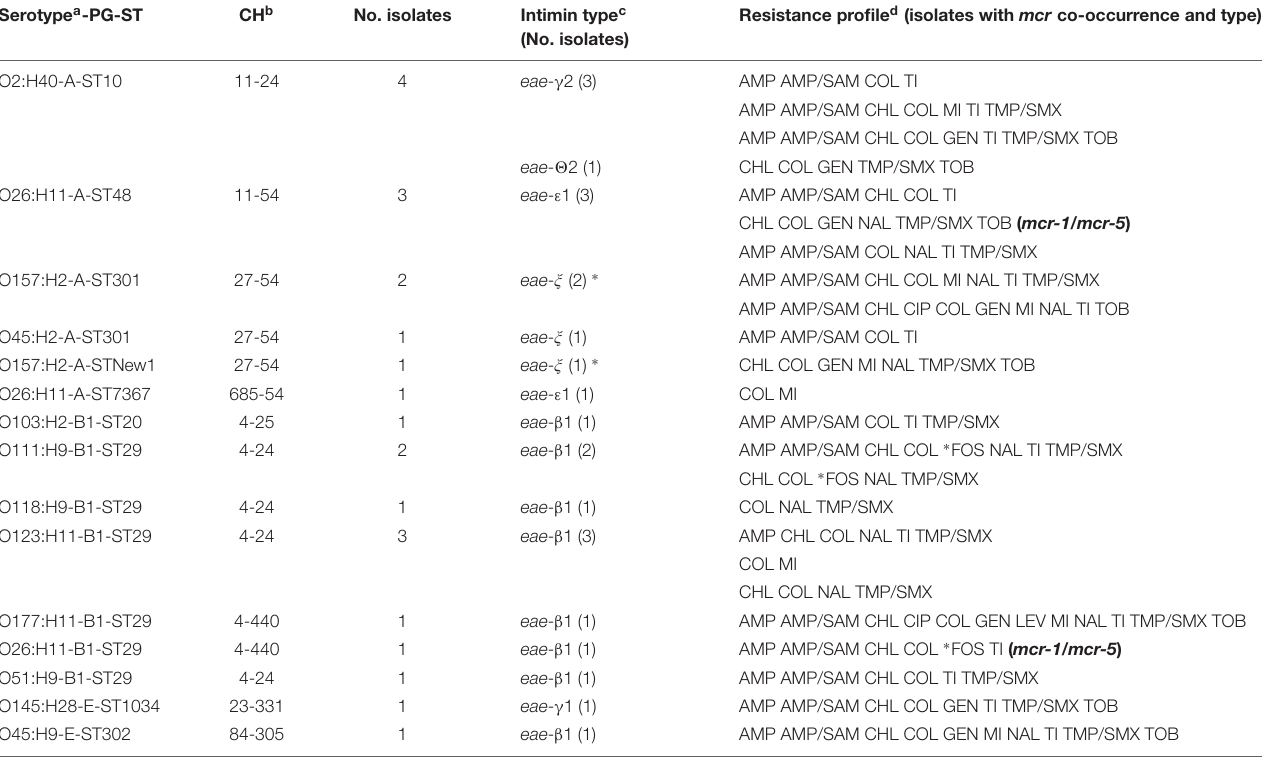
TABLE 3 | Molecular characterization of the 24 aEPEC mcr-1 -positive isolates. Serotype a -PG-ST CH b No. isolates Intimin type c